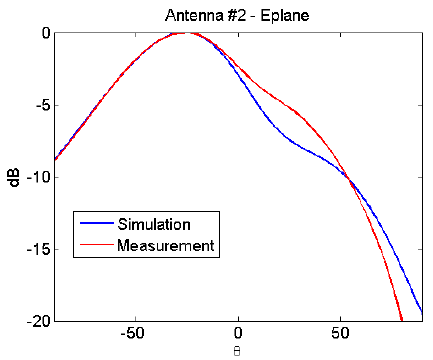
Figure 6. Comparison between measurements and simulations for antenna configuration (cid:93) 1 (upper right patch “OFF”)—E